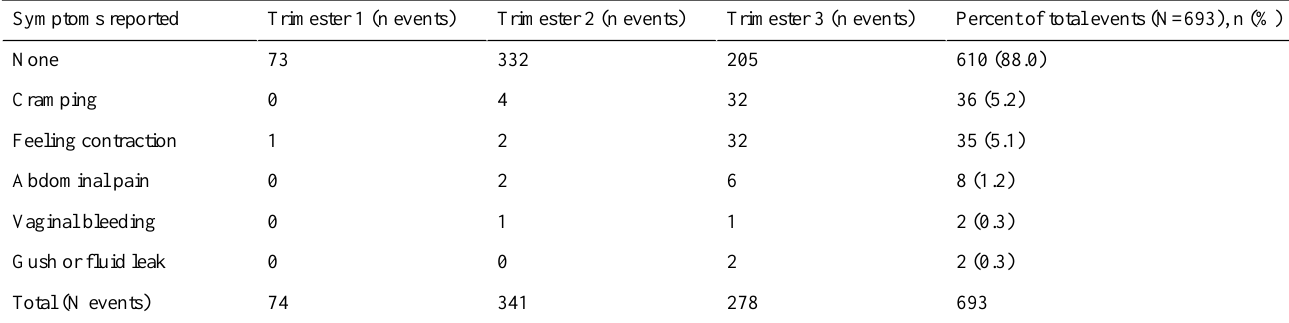
Table 6. Tally of preterm birth risk symptoms reported via the MHP app by